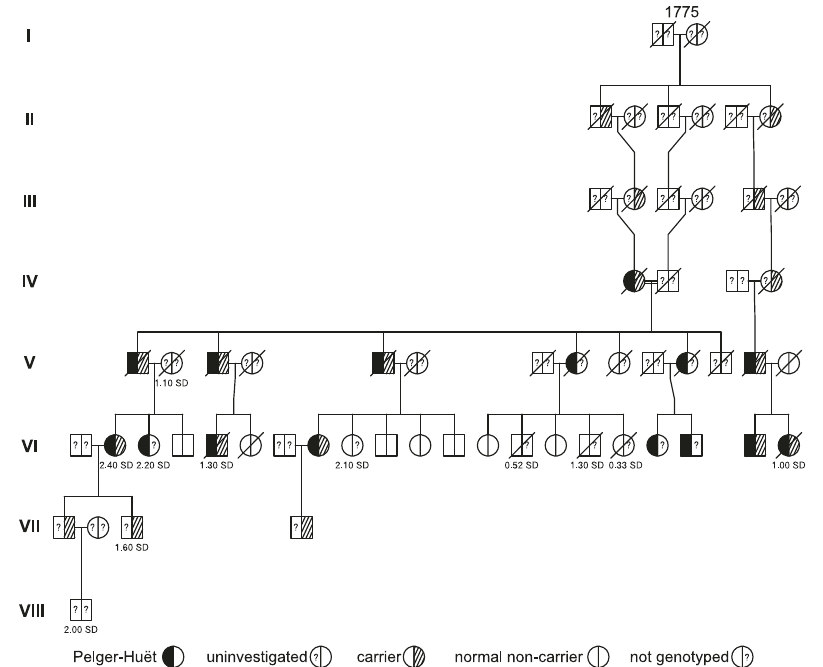
Fig. 3 Pedigree of carriers of p.Arg76Ter in LBR . All eight carriers (and ten obligate carriers) can be traced back to ancestors in the late eighteenth century. The founding couple have a total number of 9707 descendants. Roman numerals indicate generation, year of birth of the founding couple is noted above the symbols, and standardized band neutrophil fractions are noted below the symbols. Left part half- fi lled object = affected by Pelger-Huët anomaly according to ref. 22 , question mark on left side = no data for the individual. We note that no genotypic data are available for the listed carriers in the loop formed in generations II, III, and IV. Their carrier status is based on the disease state of carrier IV.1. as presented in ref. 22